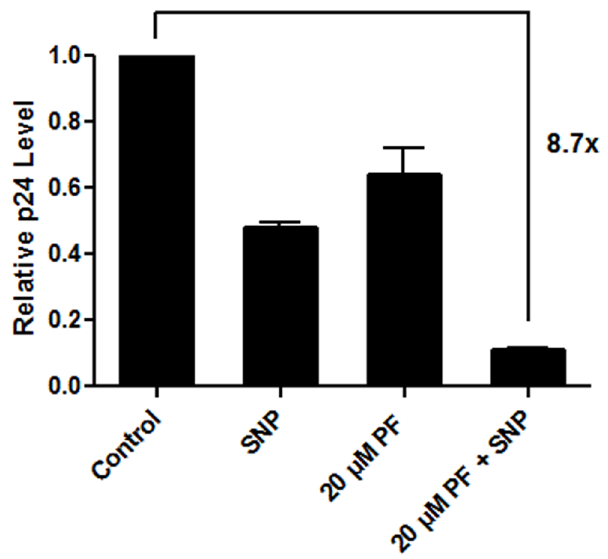
Figure 6. Inhibition of HIV-1 production from primary human monocyte-derived macrophages by perifosine. Primary human monocyte-derived macrophages were infected and cultured for 12 days in the presence and absence of sodium nitroprusside (SNP, 100 m M) and/or perifosine (20 m M), and the p24 levels of the supernatants on the 12 th day of the culture were determined. The p24 level at day 12 for each condition was normalized by the p24 level (86 pg/ml) of the media only control (no treatment).